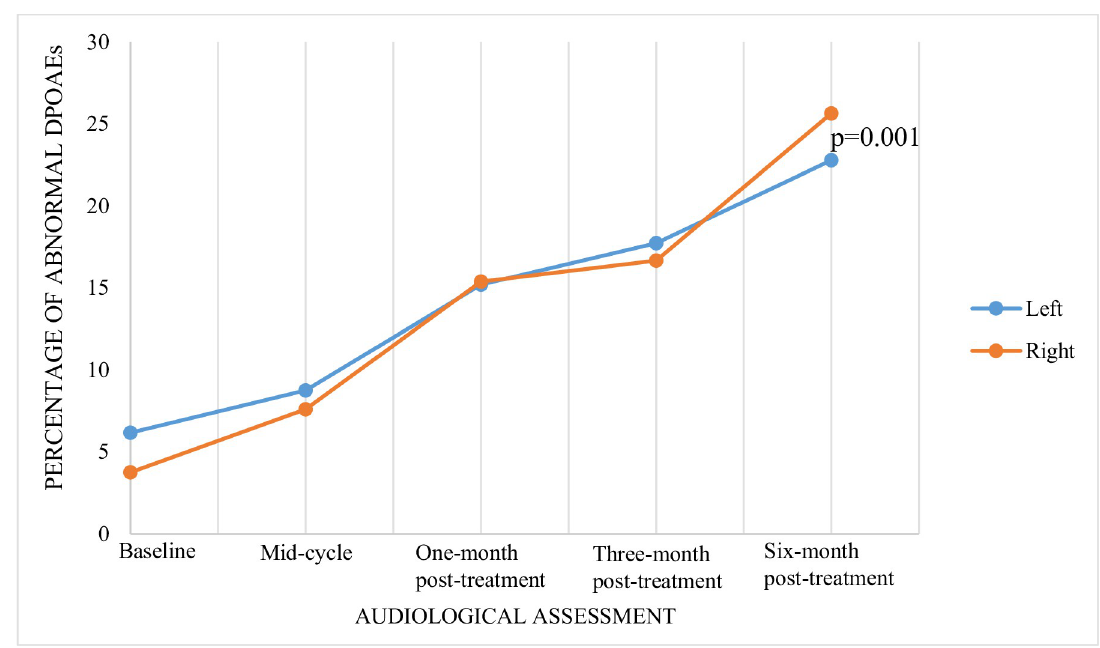
Fig 1. Percentage of abnormal Distort Product Oto-acoustic Emissions (DPOAEs) at each audiological evaluation. There is a monotonic increase (p = 0.001) in the number of abnormal DPOAEs at each audiological visit.